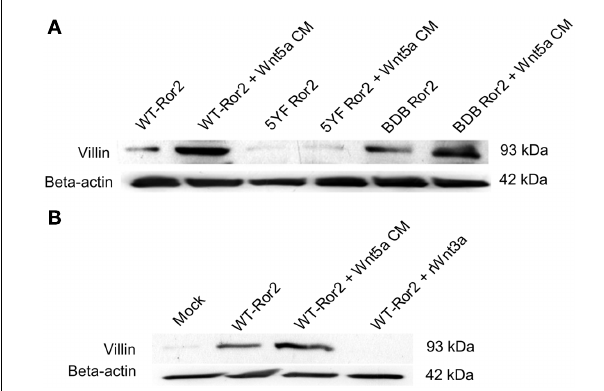
FIGURE 8 |Wnt5a treatment did not stimulate villin protein expression in 5YF Ror2-expressing HIECs but did induce villin protein expression in BDB Ror2-expressing HIECs. (A) In untreatedWT Ror2-expressing cells, villin protein expression was not detectable; uponWnt5a challenge for 24h, villin expression was substantially increased. Levels of villin protein were low in untreated andWnt5a-treated 5YF Ror2-expressing cells. Similar Wnt5a treatment upregulated the amount of immunoreactive villin in cells transfected with BDB Ror2. β -actin immunoreactivity was assessed to confirm equivalent loading.These results are representative of three separate experiments. (B) Incubation with recombinantWnt3a protein did not stimulate villin protein expression in Ror2-overexpressing HIECs.Villin protein expression was not detectable in untreated mock-transfected HIEC, but was slightly enhanced in untreatedWT Ror2- expressing cells.Villin protein expression was noticeably increased withWnt5a CM-challenge for 24h inWT Ror2-overexpressing cells. In similarly transfected cells, rWnt3a incubation for a 24-h period did not induce increases in villin protein. β -actin immunoreactivity was assessed to confirm equivalent loading.These results are representative of three separate experiments.